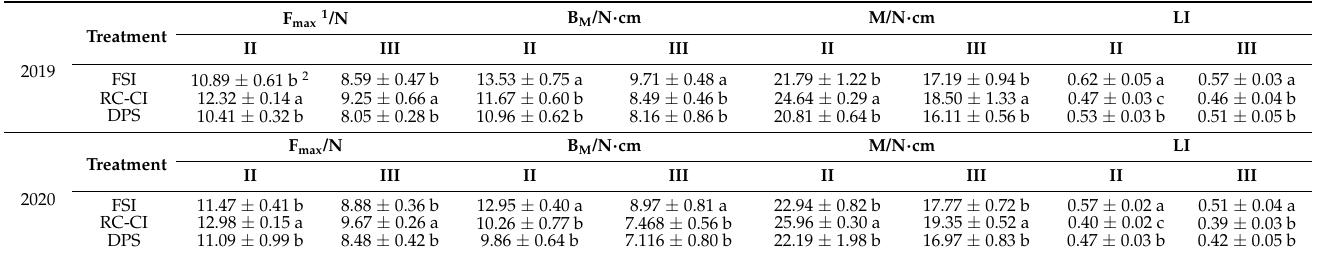
Table 6. Mechanical index of rice stems in different irrigation and drainage modes.